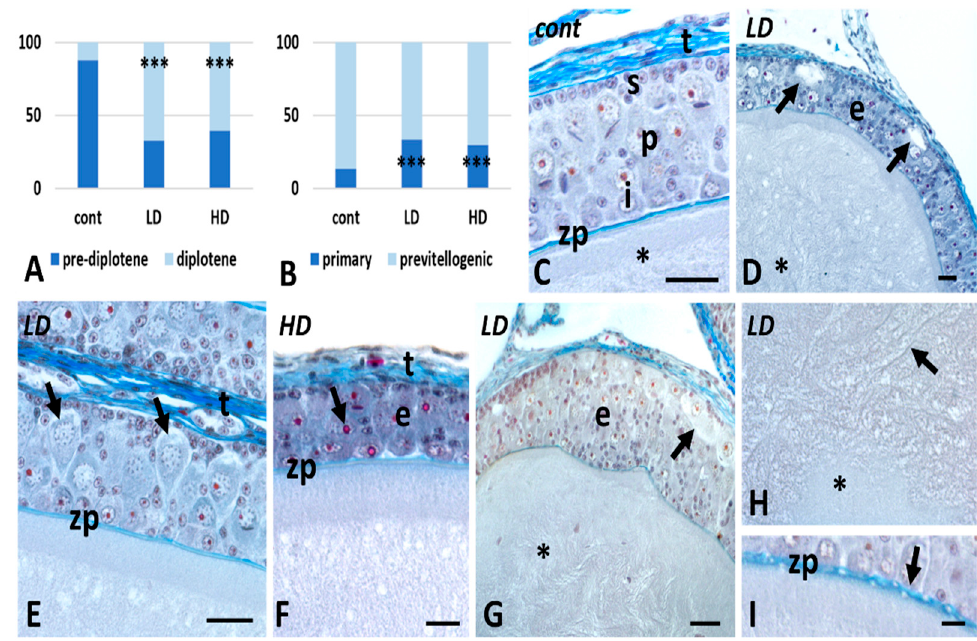
Figure 1. Effects of glyphosate (low LD and high HD doses) on follicle anatomy. Significant increase in prefollicular diplotene oocytes ( A ) and primary follicles ( B ) (***, p < 0.001). ( C ) Oocyte with regular cytoplasm (*), zona pellucida (zp), and polymorphic epithelium composed of small (s), pyriform (p), and intermediate (i) cells. Connective theca (t). ( D ) Apoptotic follicle cells (arrows) in the epithelium (e) and disorganized oocyte cytoplasm (*). ( E ) Detail of several early apoptotic cells (arrows). Notice the loss of contact with adjacent cells. Group of thecal cells (t). ( F ) Detail of a patch of condensed follicular epithelium (e). Cells still have a nucleolus (arrow) and the theca is compacted (t). ( G ) Thickened epithelium (e) with several apoptotic cells (arrow). Altered oocyte cytoplasm (*). ( H ) Detail of the oocyte cytoplasm with homogeneous (*) and grossly fibrous (arrow) areas. ( I ) Zona pellucida with discontinuities (arrow). Galgano’s trichrome staining; scale bars: ( C – G ) 25 µ m; ( H , I ) 10 µ